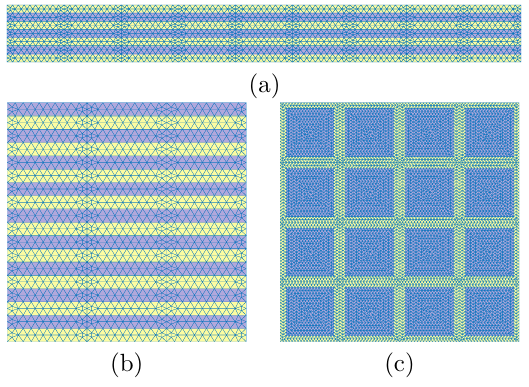
Figure 1. Three academic problems taken from [11]: a) the laminated beam, b) the 3 × 3 grid of periodic, layered subdomains, and, c) the 4 × 4 grid of peridodic subdomains with immersed stiff square inclusion.